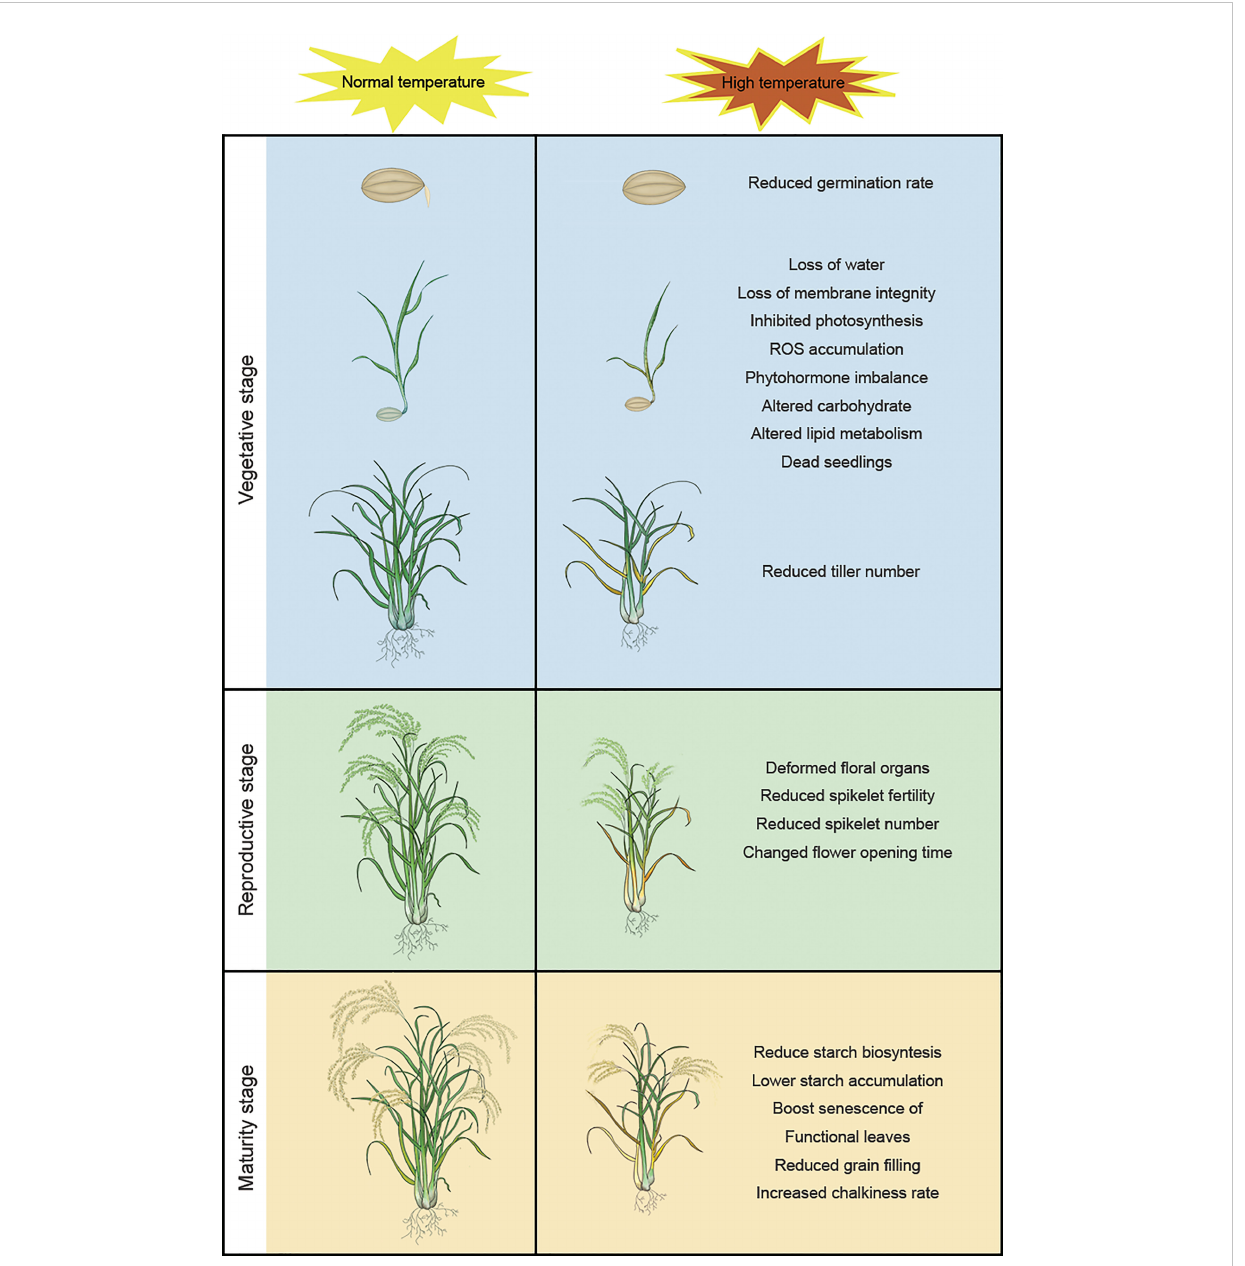
FIGURE 1 High temperature has different effects on rice at different stages of the plant life cycle: reduced germination rate, loss of water, loss of membrane integrity, inhibited photosynthesis, ROS accumulation, phytohormone imbalance, altered carbohydrate, altered lipid metabolism, dead seedlings, and reduced tiller number at the vegetative stage; deformed fl oral organs, reduced spikelet fertility, reduced spikelet number, changed fl ower opening time, reduced spikelet fertility, reduced spikelet number, and altered fl ower opening time at the reproductive stage; reduce starch biosynthesis, lower starch accumulation, boost senescence of functional leaves, reduced grain fi lling and increased chalkiness rate at the maturity